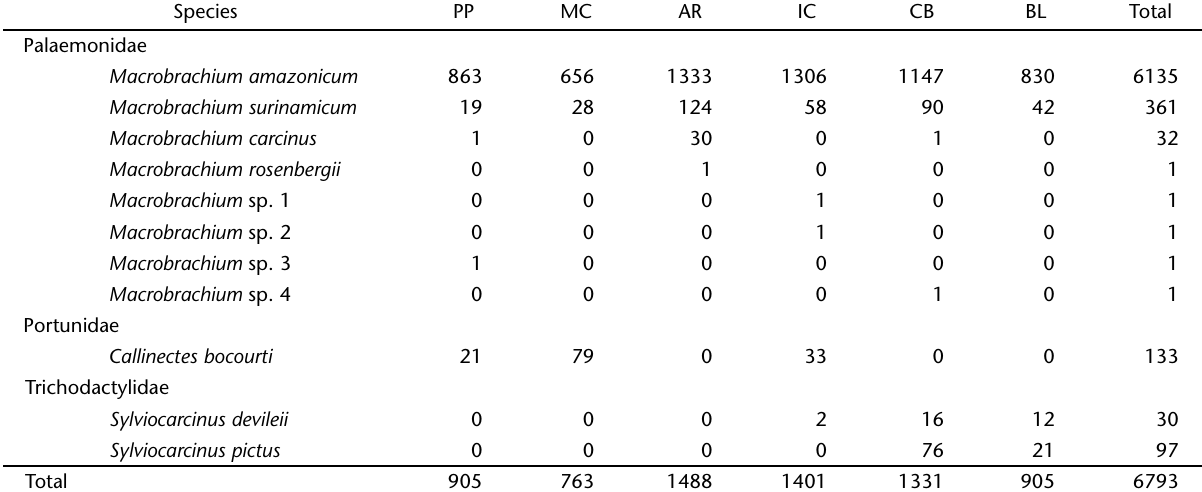
Table I. Mean salinity and temperature of the water recorded at the sites at the Guajará Bay (Pará, Brazil) monitored during the present study, from May 2006 to April 2007. (SD) Standard Deviation. Site Porto do Pelé Arapiranga Icoaraci Combu